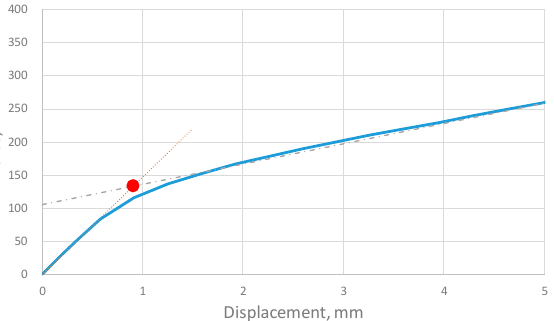
Figure 13. Ultimate strength for L6- ϕ 60- θ 00 considering the corrosion wastage.